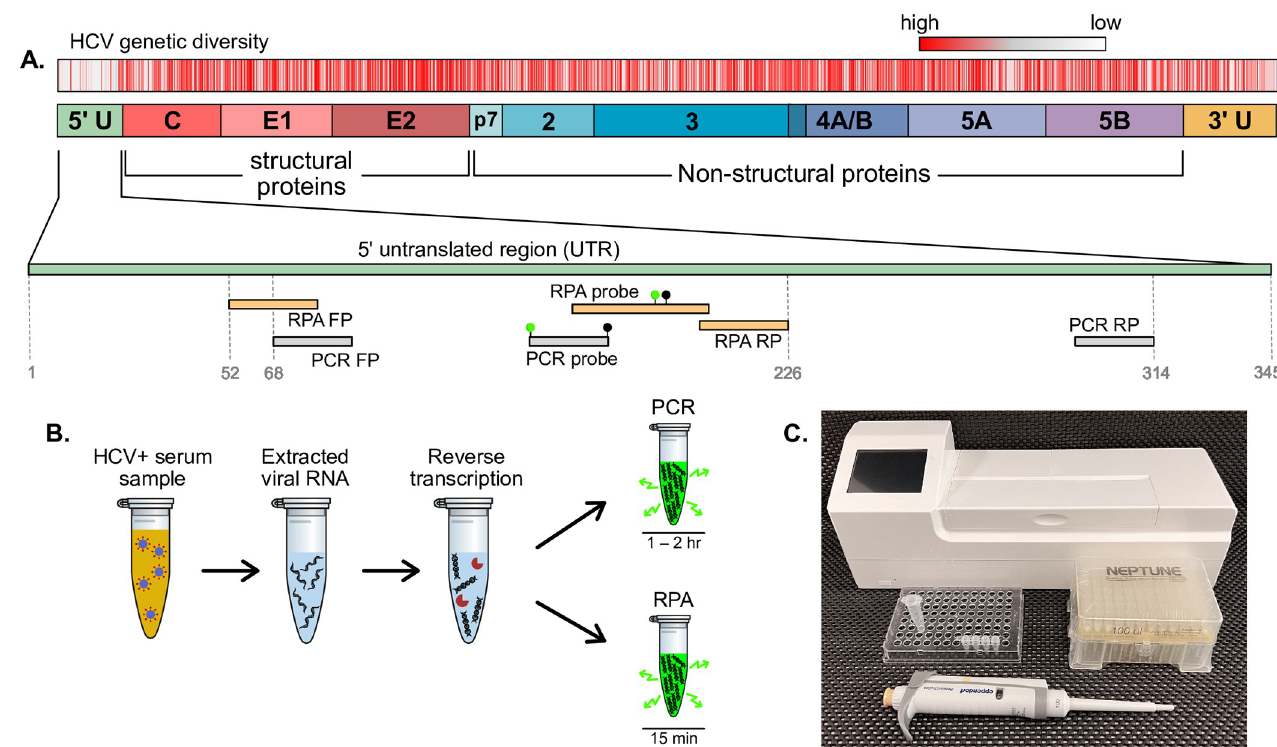
Fig 1. RT-RPA target sequence location and overview of assay. (A) HCV RPA assay was designed to target the 5’ untranslated region (UTR) gene which has the highest homology across all genotypes. We plot locations of mismatches in red for an alignment of the reference sequences of the six genotypes of HCV, with regions of high homology colored grey or white. We show the locations of the RPA primers and probe on 5’ UTR, as well as the published PCR primers and probe [26]. (B) Schematic of the experimental protocol for HCV RNA detection using either RT-RPA or RT-PCR. Viral RNA is extracted from human serum using a column-based solid phase extraction kit, RNA is reverse transcribed into complementary DNA (cDNA), and HCV cDNA is detected with either PCR (1–2 hr runtime) or RPA (15 min runtime). (C) A simple experimental setup for reverse transcription and RPA includes basic laboratory consumables, a pipette, and a benchtop fluorometer with an integrated heating block (Axxin